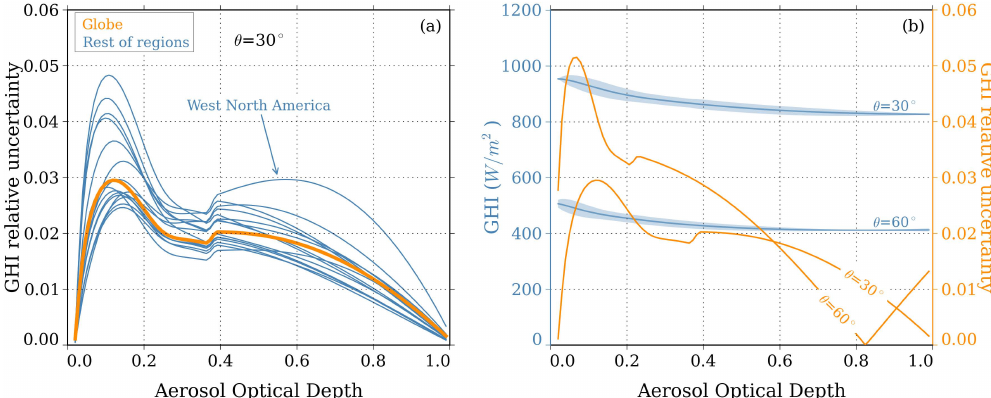
Fig. 9. Same as Fig. 8, but for global horizontal irradiance